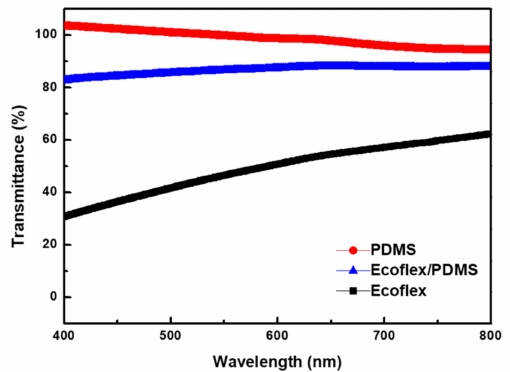
Figure 1. Light transmittance of the prepared stretchable